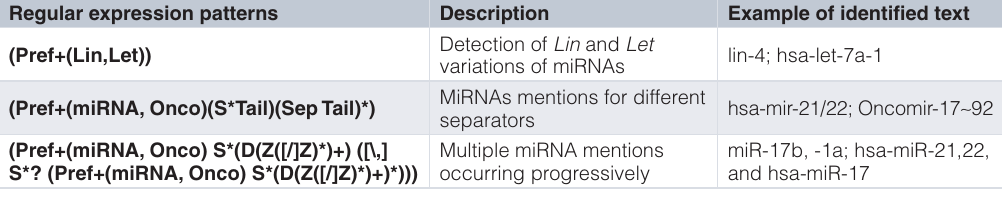
Table 4. Regular expression patterns used for miRNAs identification. Aliases used to form the final regular expression, see Table 5, are highlighted in bold. Regular expression